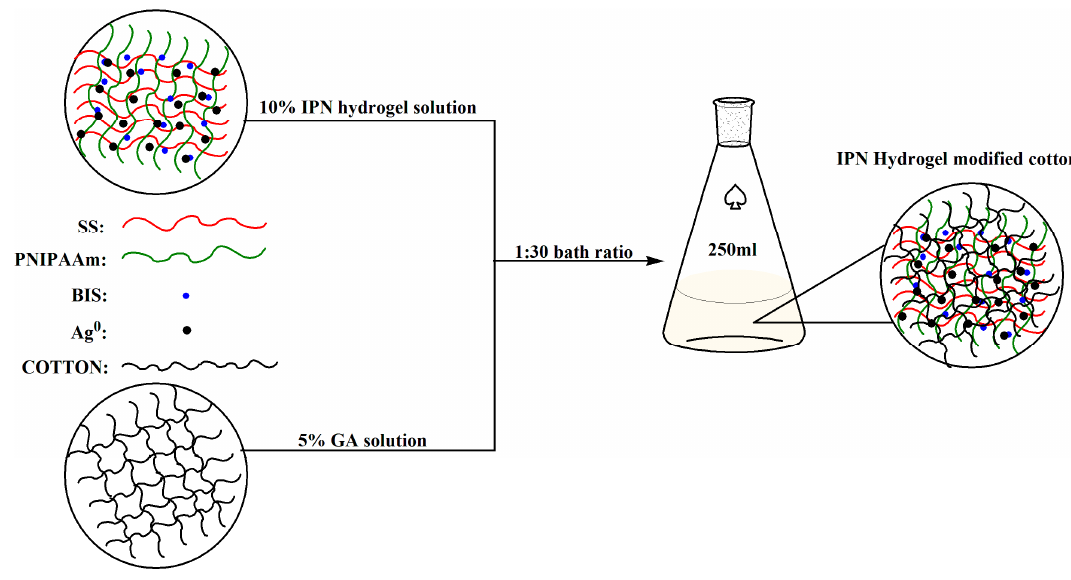
Figure 2. IPN hydrogel modified cotton process.